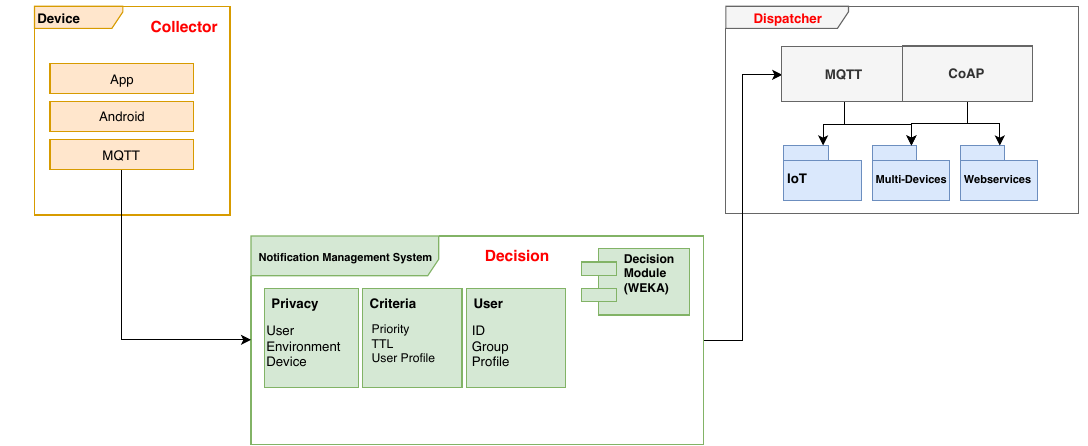
Figure 2. Notifications Management System